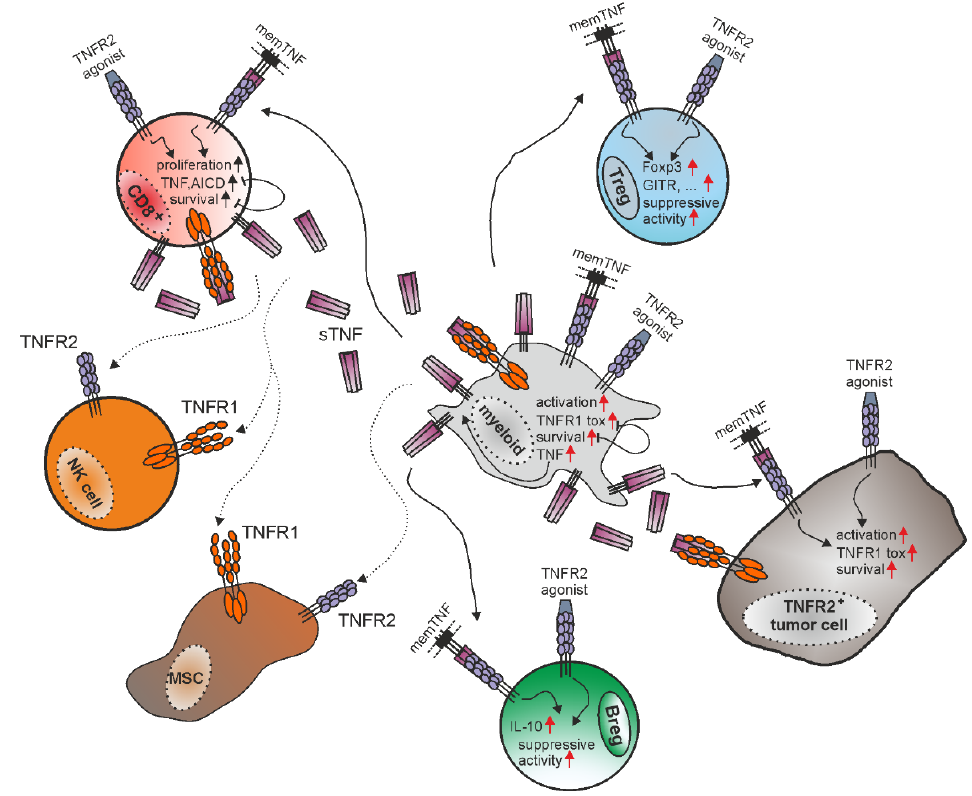
Figure 3. The biology of TNFR2, e.g., in the tumor microenvironment, is determined by the mutual influence of various TNF and TNF receptor expressing cell-types and a complex intracellular signaling network of the two TNF receptors. TNFR2 is expressed by various immune cells with partly opposing functions, e.g., immune suppressive Tregs but also CD8 + T-cells and various types of myeloid cells. Due to its ability to modulate the quality of TNFR1 signaling (inflammation versus cell death), TNFR2 furthermore elicits, in a context-dependent manner, quite contrasting effects on the same type of immune cell (survival versus death, e.g., in CD8 + T-cells and macrophages). In fact, for Tregs, macrophages and CD8 + T-cells, comprehensive literature is available describing partly counteracting activities of TNFR2 at the cellular level. This also applies for other cell types in which TNFR2 activities are less well investigated, such as, for example, NK cells and mesenchymal stem cells (MSCs) or even TNFR2-expressing tumor cells. For further details, see main text.